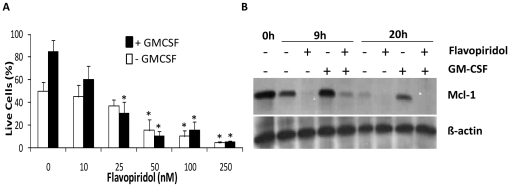
Flavopiridol inhibits upregulation of Mcl-1 by GM-CSF.(a). Neutrophils were incubated with medium alone, or medium containing 100 nM flavopiridol in the absence (open bars) or presence of (filled bars) of 50 ng/ml GM-CSF. Live cells were detected by their ability to retain DiOC6 and data are mean ± s.d. of 3 separate experiments. * indicates p<0.05 for control versus flavopiridol treated cells. (b). The same cells were extracted and measured for Mcl-1 content by western blotting. Blots were probed for β-actin to confirm equal loading.